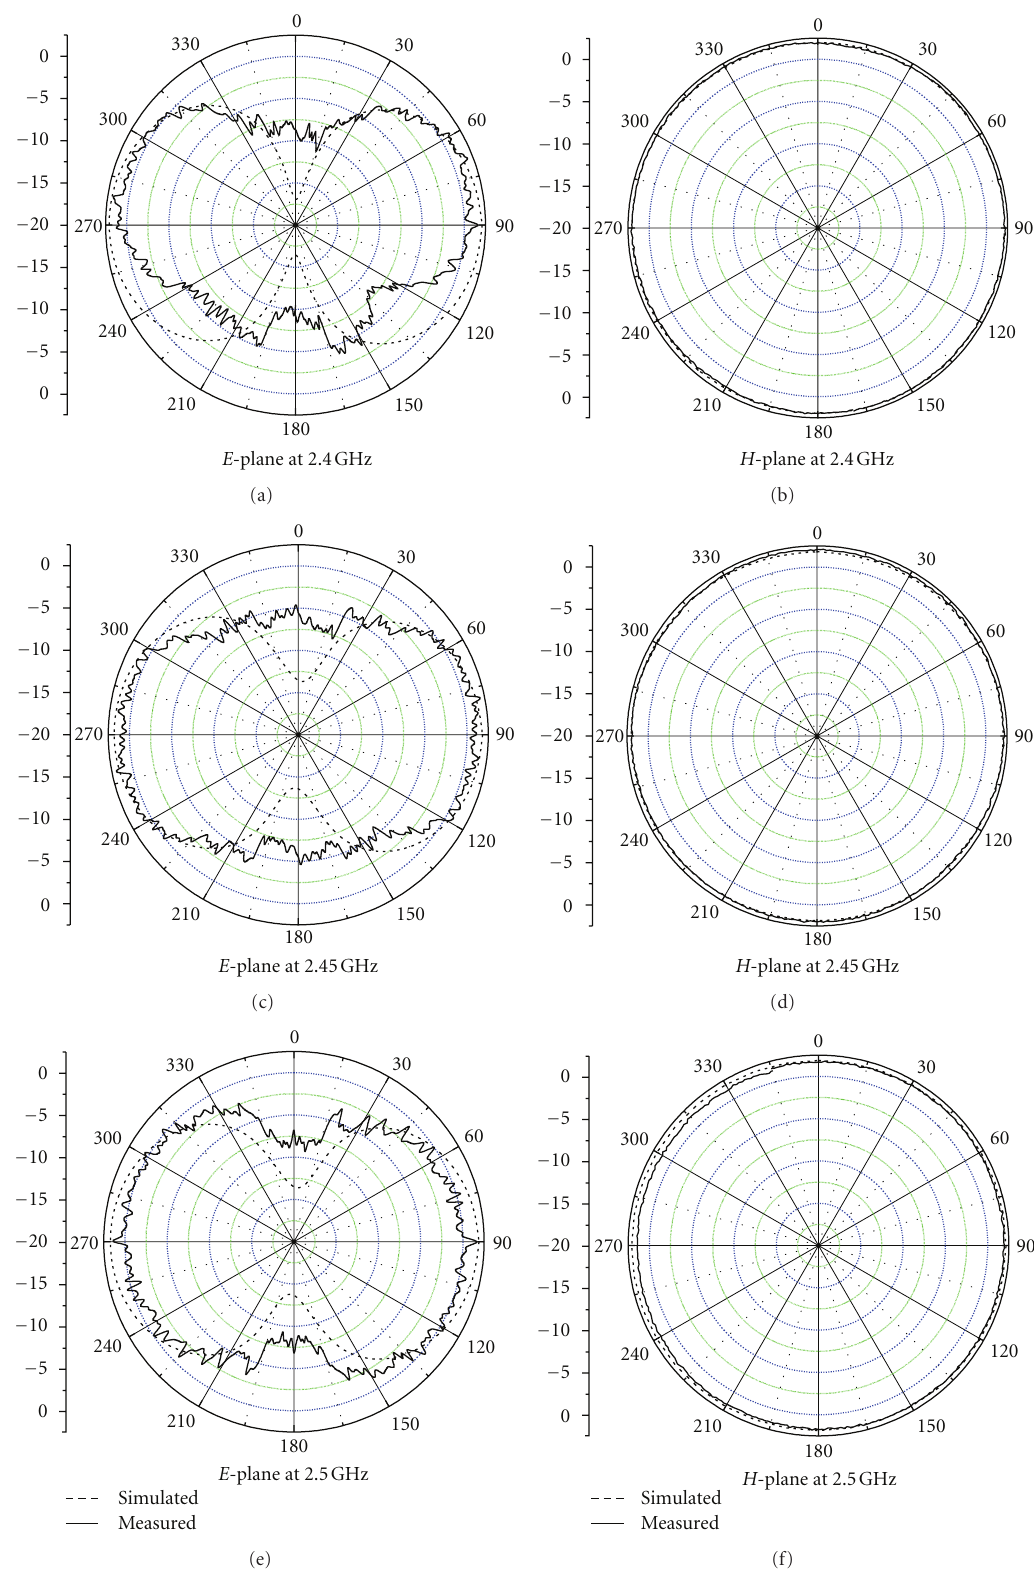
Figure 9: The radiation pattern of the proposed antenna in the working